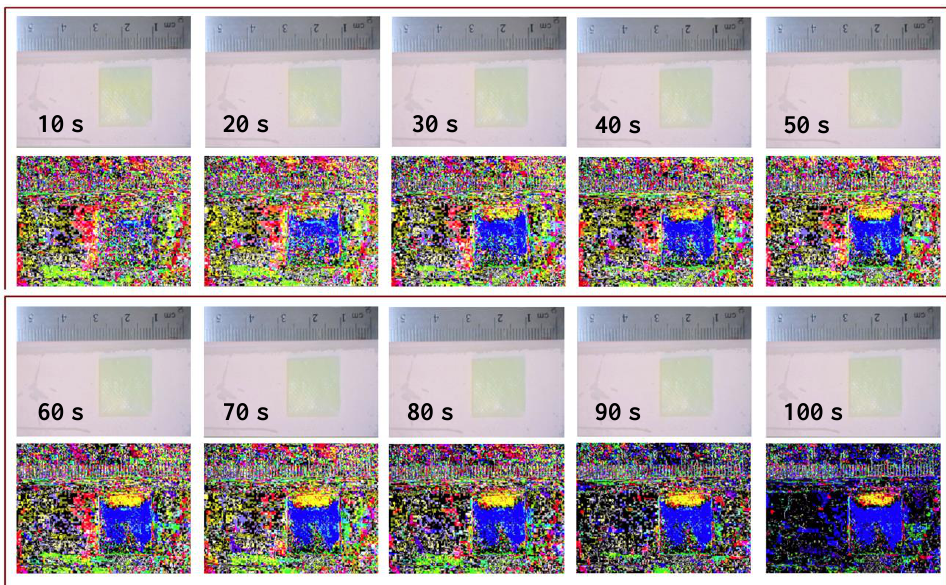
Figure 6. This figure shows 10 sets of 2 images, where the top image is the unprocessed still frame that includes a time stamp, and the bottom image is the result of subtracting that frame from the initial frame at time zero. This time-lapse comparison of subtracted images to unprocessed images is the series of frames where solution (1) is 50% glycerol (yellow) and solution (2) is 100% water (blue).